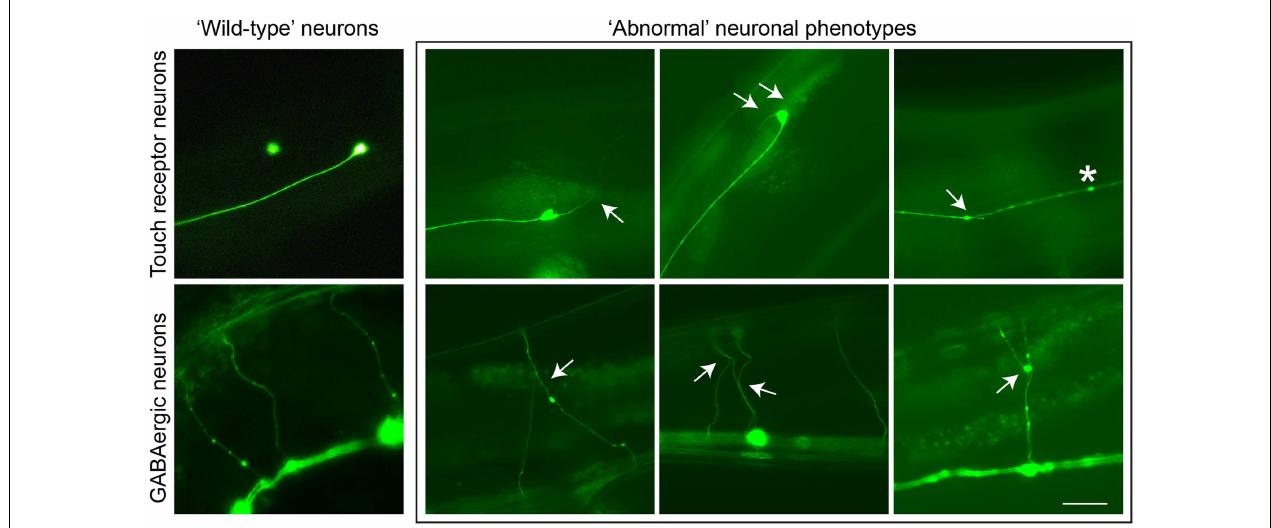
motor neurons (bottom), branching from commissures extending dorsally can be visualized.These phenotypes usually accumulate in late adulthood in wild-type animals, but in ptl-1 mutant strains these structures can be seen starting in early to mid-adulthood. Arrows indicate branching, asterisks indicate beading. Scale bar=50 µ .Ventral is